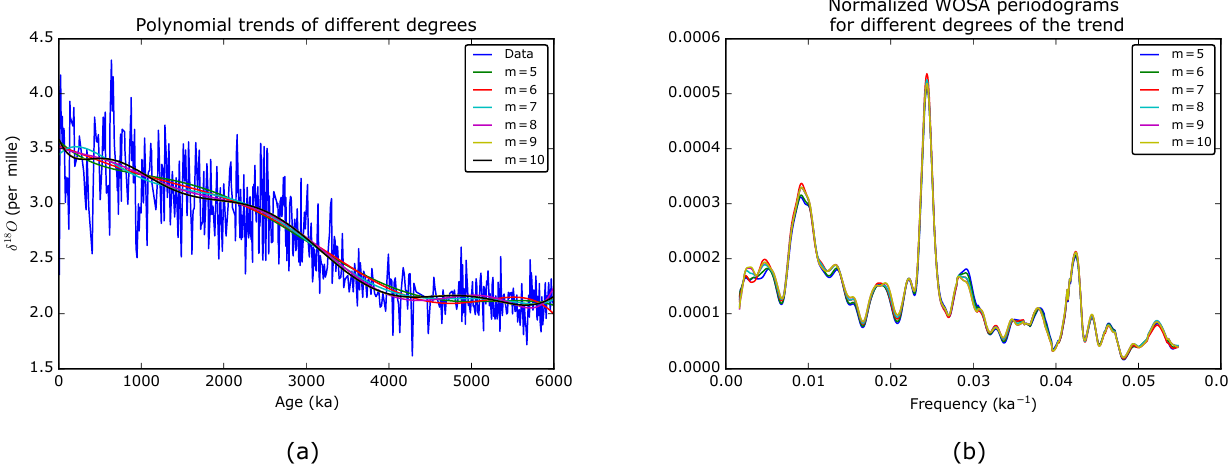
Figure 11. (a) Trends of different degrees for the time series. (b) Weighted WOSA periodograms for different degrees of the trend. Each periodogram is normalised like in Eq. (58) in order to make a meaningful comparison.